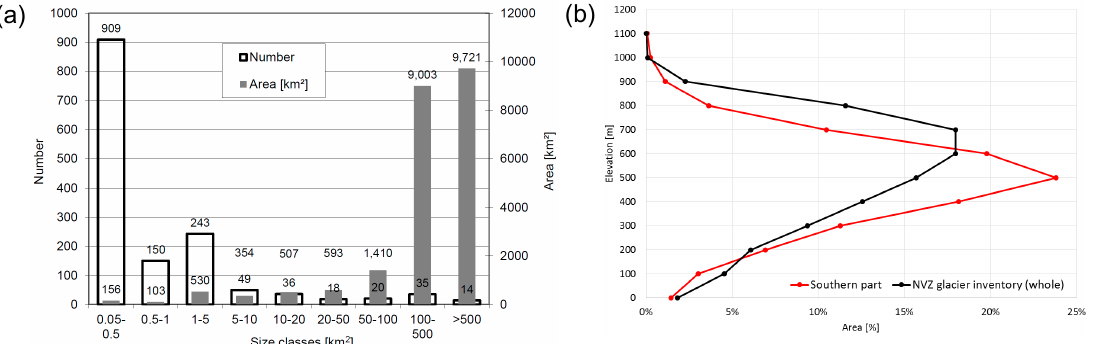
Figure 5. ( a ) Area covered and number of glaciers per size class; ( b ) area-elevation distribution for the whole island and the southern part.